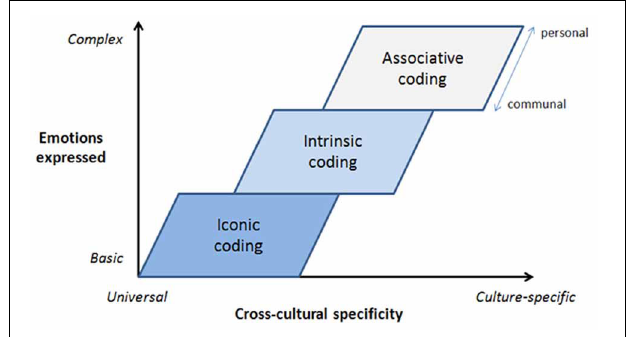
FIGURE 2 | Multiple-layer conceptualization of musical expression of